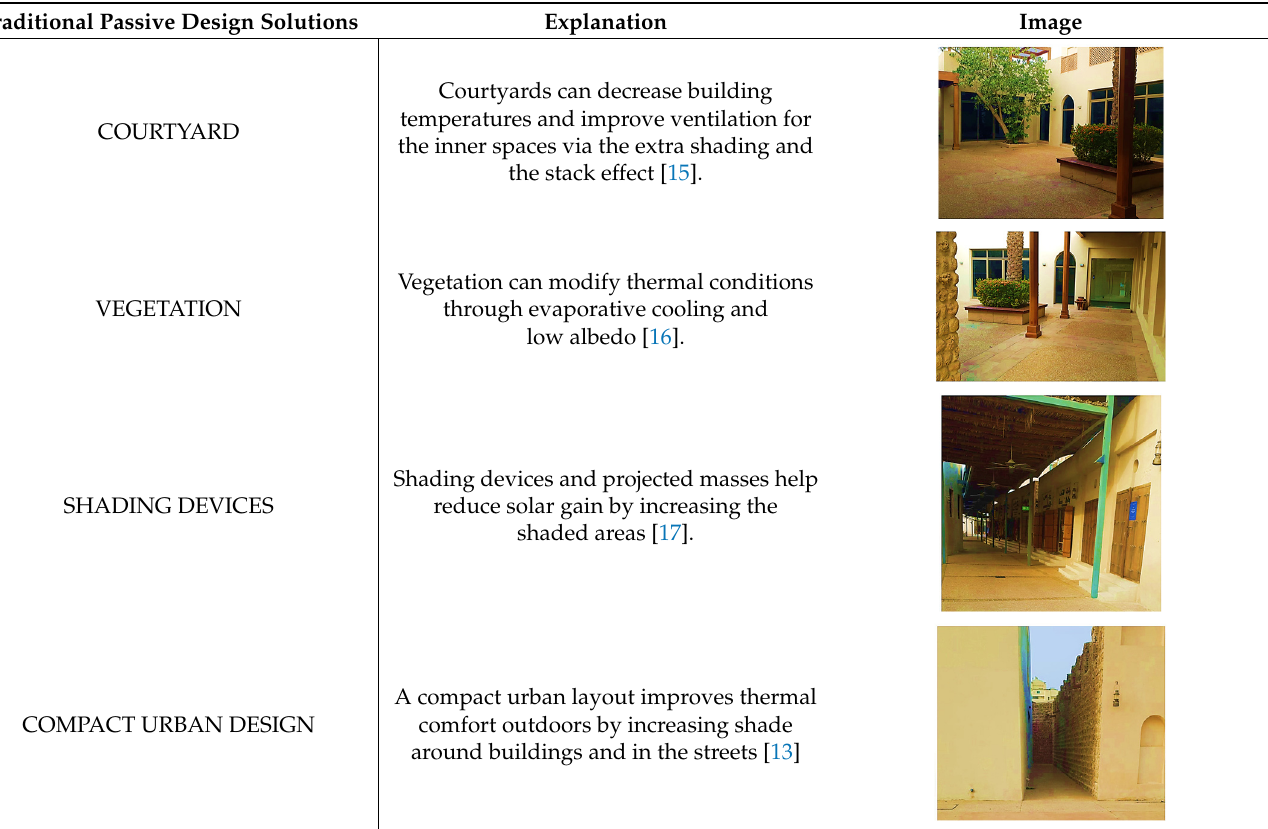
Table 1. Some passive design solutions in Al Marijah, old Sharjah.